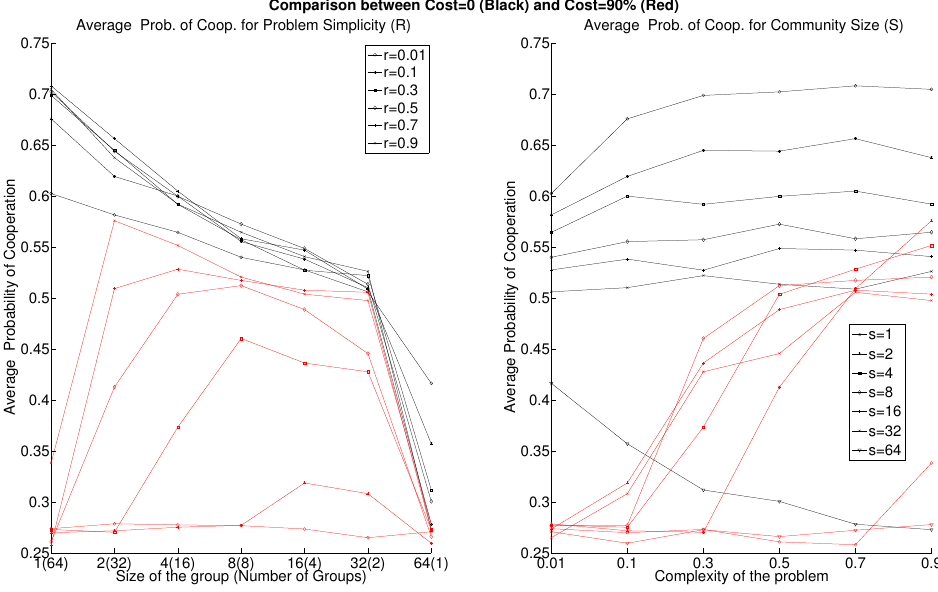
Figure 4. Final average probability of cooperation for the condition with the cooperation cost equal to 0 (dark lines) and the cooperation cost equal to 90% (red lines), compared to the problem simplicity ( left plot) and to the group sizes ( right